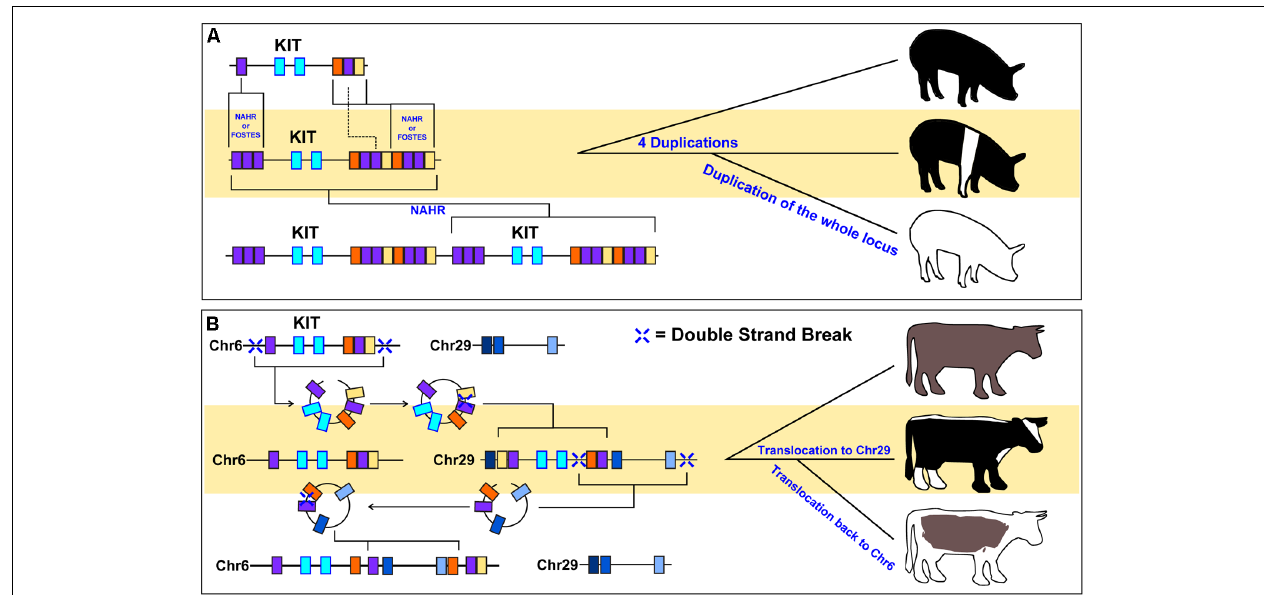
Translocation of the KIT locus, in addition to surrounding regulatory genomic segments, has resulted in distinct coloration phenotypes in cattle. It was discovered that the color-sided phenotypes in Belgian Blue (middle) and Brown Swiss (bottom) cattle were achieved by two translocations of the KIT locus to different cattle chromosomes.The rearrangement of surrounding genomic segments (colored boxes) near the KIT locus at each translocation point suggested that circular intermediates were involved in the movement of this